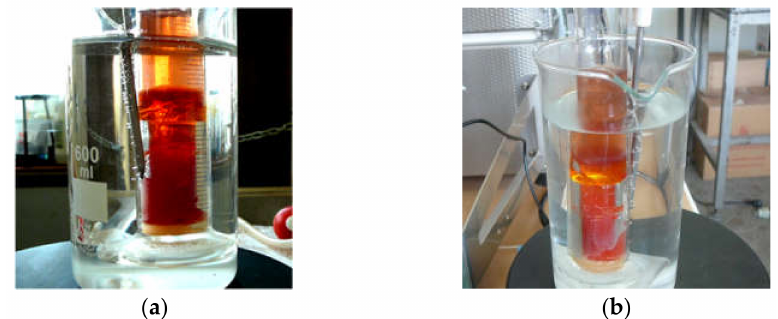
Figure 6. Appearance of RF gels: ( a ) R/C = 500, ( b ) R/C = 200.